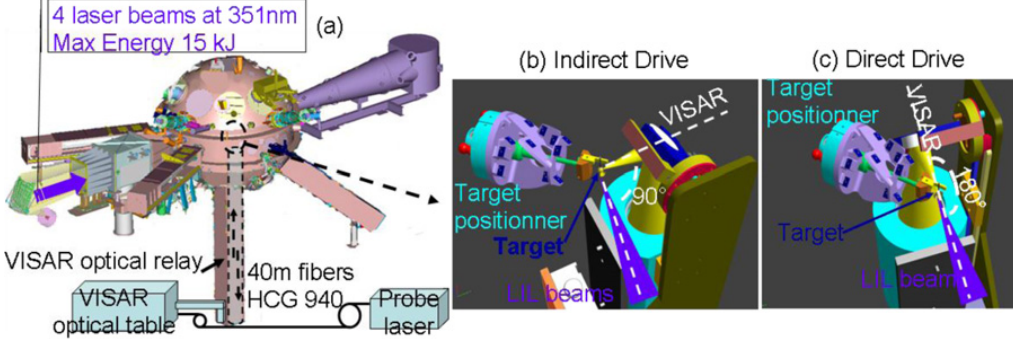
Figure 1. VISAR implementation on LIL Facility target bay (a); Indirect (b) and direct (c) drive configuration.